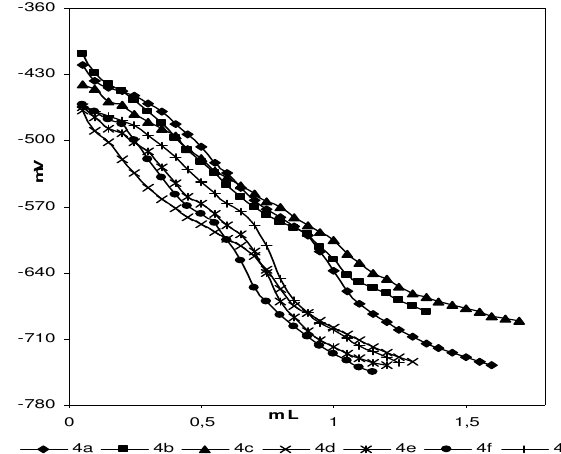
Figure 5. Potentiometric titration curves of 0.001 M solutions of compounds 4a-g titrated with 0.05 M TBAH in DMF at 25 °C. Table 2. The HNP and the corresponding p K alcohol, tert -butyl alcohol, DMF and